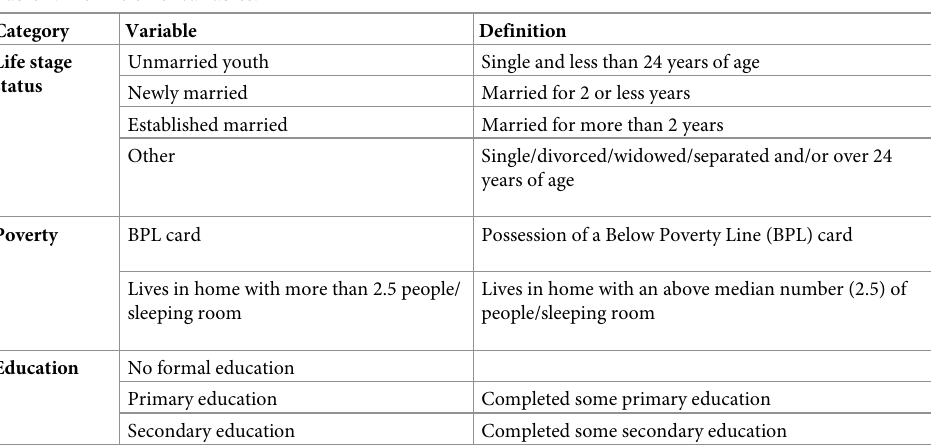
Table 1. Definition of